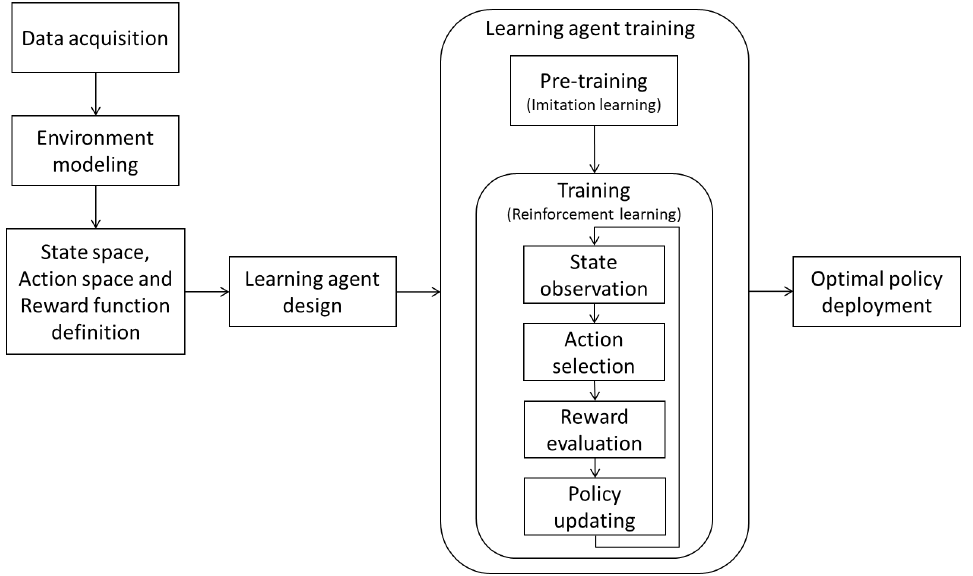
Figure 1. Schematic representation of proposed